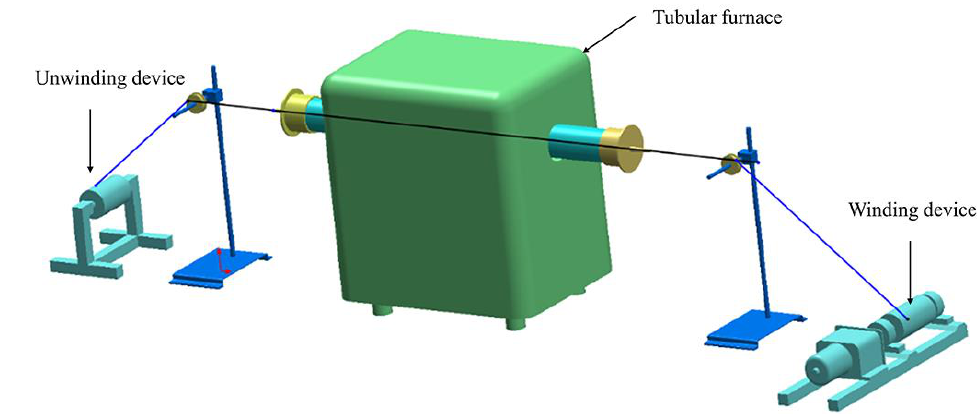
Figure 1. The equipment for preparing the carbon fiber. Table 1. The heat treatment temperatures and times of the fibers.